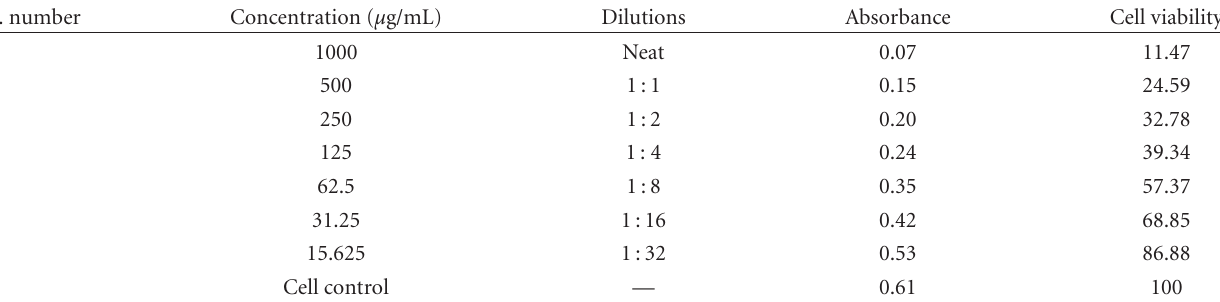
Table 2: Showing the e ff ect of anthocyanin on MCF-7 cells extracted from red sorghum bran by using acidified methanol. S. number